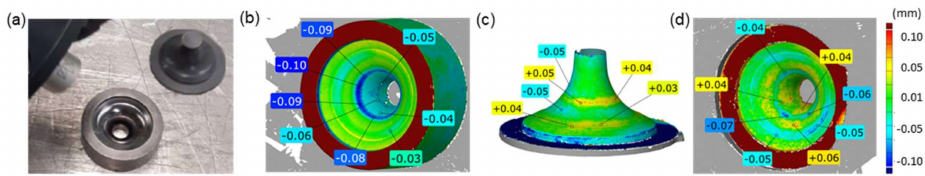
Figure 2. The idea of the developed method of die wear analysis: ( a ) 3D scanning—measurements of the die and the replication mass imprint, ( b ) result of a direct measurement of the die burdened with errors caused by the imperfection of the scanning techniques, ( c ) results of a measurement through scanning of the replication mass imprint in the die, ( d ) result of a measurement (scanning) showing the real surface state of a worn tool without errors obtained by way of superimposing a reversed replica image onto a CAD